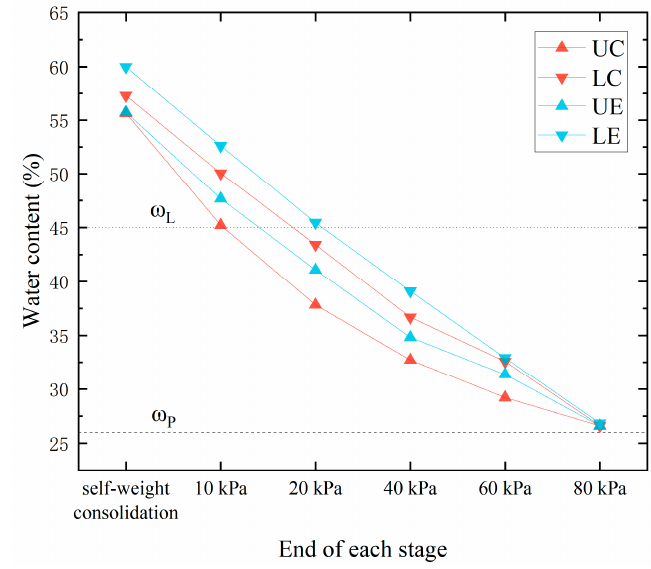
Figure 7. Moisture content in different locations at the end of each stage.